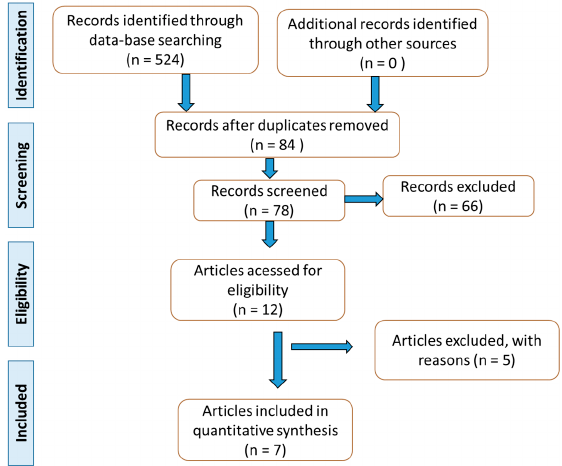
Figure 1. Flow diagram according to PRISMA guidelines [15] .